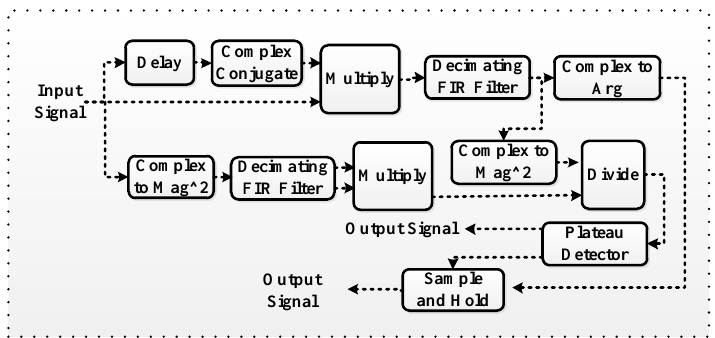
Figure 4. Architecture of WiFi Preamble